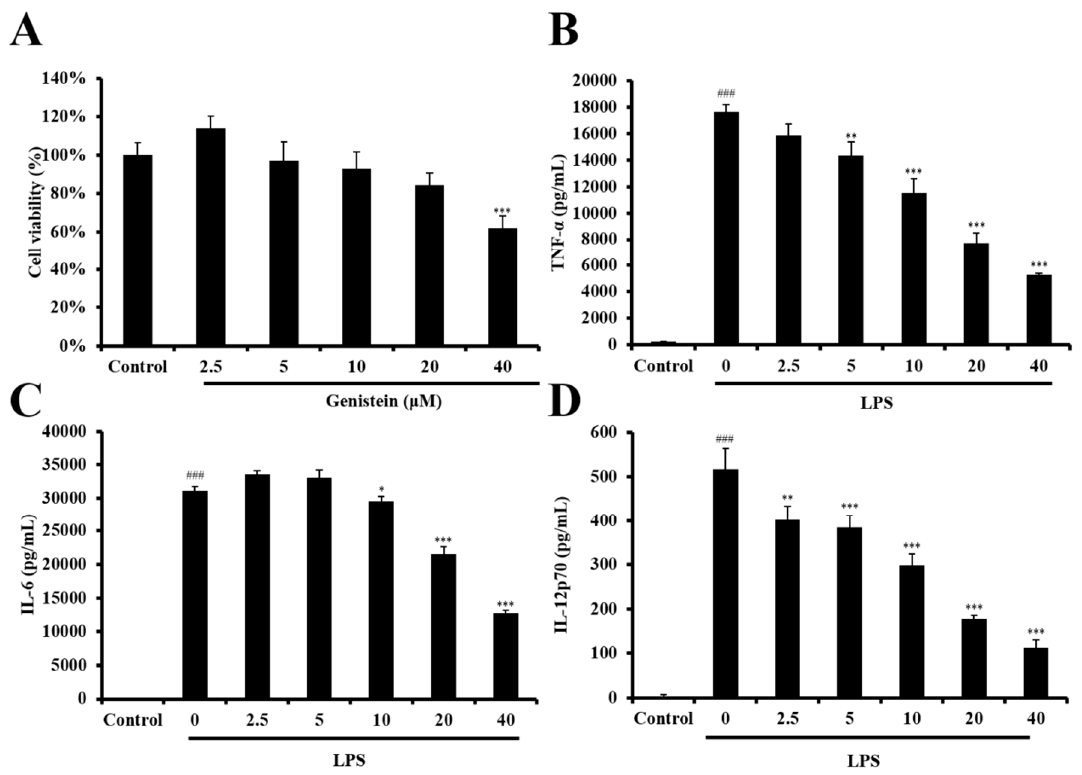
Figure 6. The effect of genistein on cell viability (A) and the production of pro-inflammatory cytokines in LPS-stimulated DCs (B, C, and D). ( A ) DCs were treated with genistein at various concentrations for 24 hours, and then their viability was measured by the CCK-8 assay (Sigma). DCs were untreated or treated with LPS (100 ng/mL) and LPS + genistein (2.5, 5, 10, 20, and 40 μ M), as indicated. Supernatants were collected 6 h after treatment. The production of the cytokines TNF- α ( B ), IL-6 ( C ), and IL-12p70 ( D ) was measured by ELISA. The data shown are the mean ± SD of three independent experiments. ### p < 0.001; * p < 0.05; ** p < 0.01; *** p < 0.001 (Scheffe’s test) for comparisons of the genistein-treated and untreated LPS-stimulated DCs.